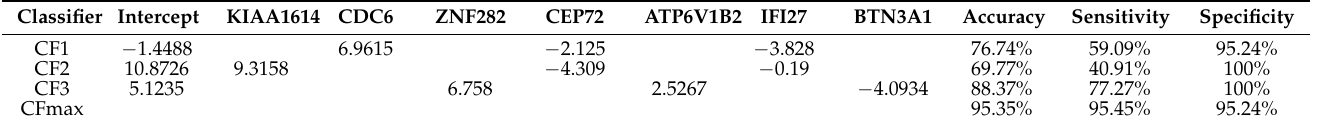
Table 17. GSE184401: Characteristics of the top-performing seven-gene classifier. CF1, CF2, CF3 are the first, second and third individual classifiers for data of severe COVID-19 condition vs. mild infection.